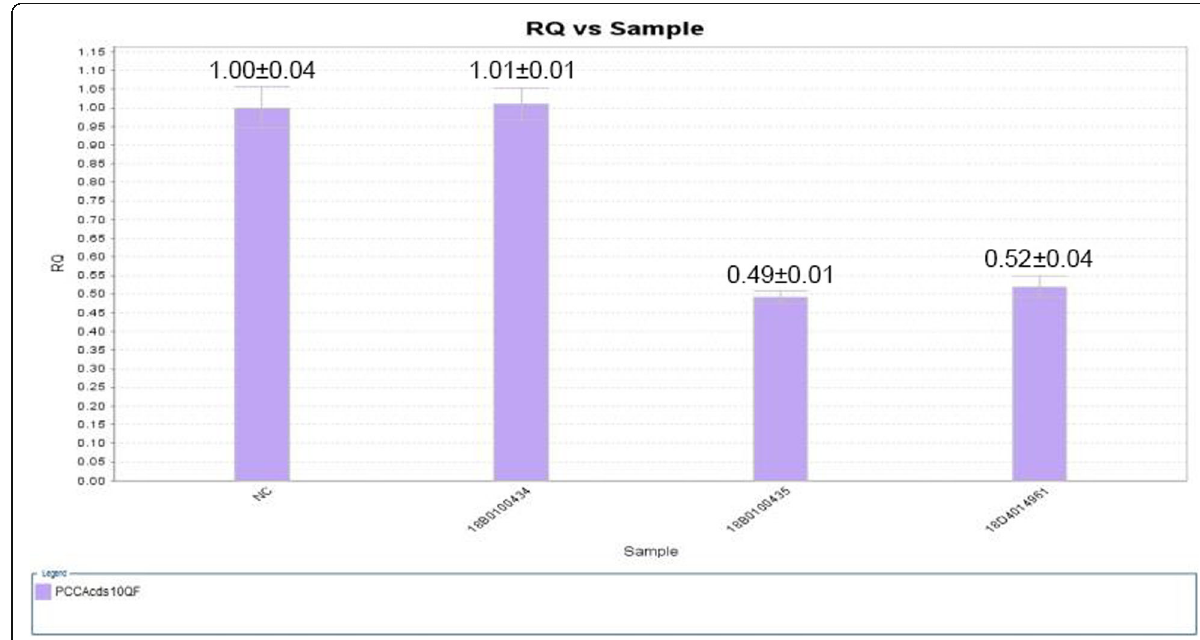
Fig. 3 Confirmation of the delins mutation using qPCR. Relative quantification (RQ) of the DNA copy number of the partial exon 10 (Purple pillars) was selected for an independent determination. NC refers to the control sample, 18B0100434 refers to the mother of the patient, 18B0100435 represents the father of the patient, 18D4014961 refers to the patient. The error bars represent standard deviation (SD) of the predicted value. Numbers shown are mean values ± SD of each sample. RQ = 2 - △△